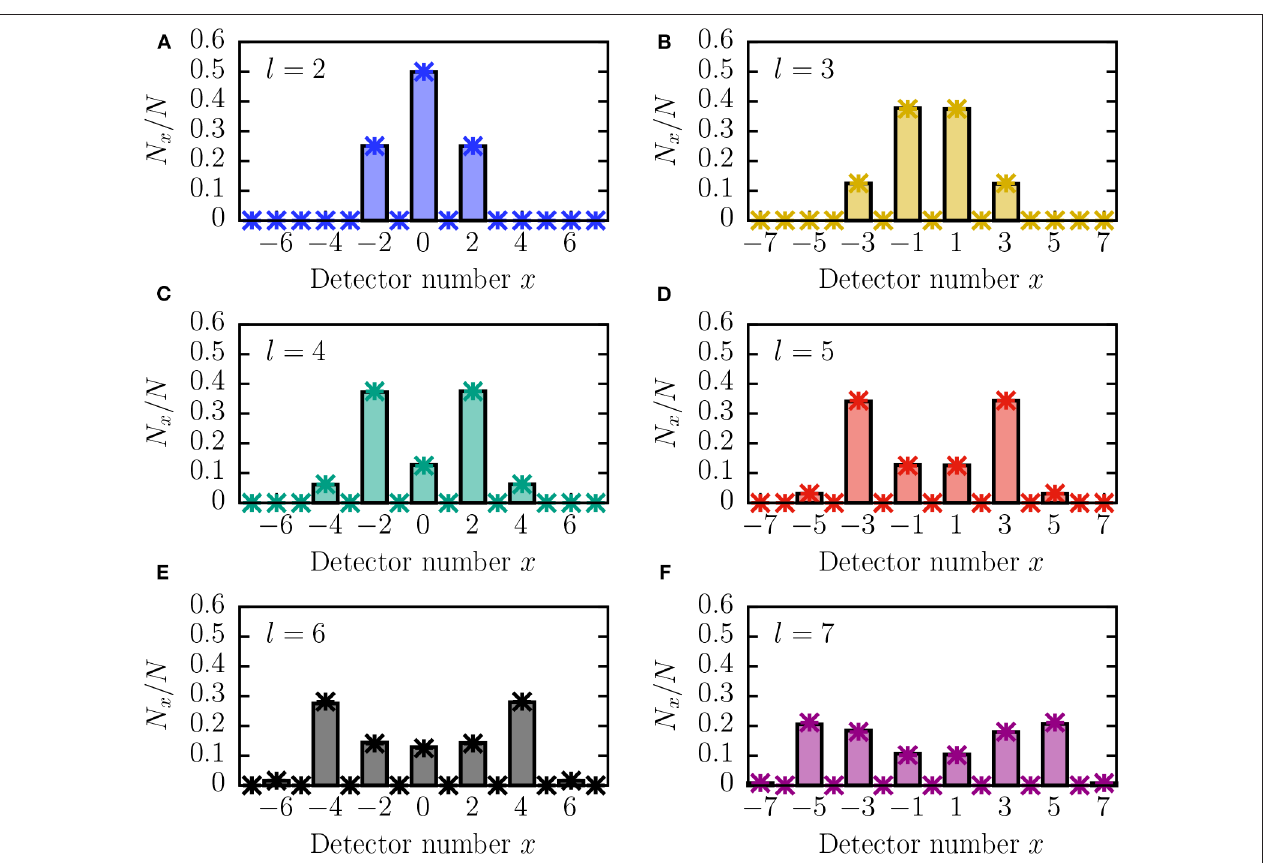
FIGURE 2 | Results for the normalized number of detector counts N x / N as a function of the detector number x , obtained by a DES of the QW for N π/ 2 and ϕ 2 π/ 2 and for different numbers of steps l repetitions, ϕ 1 2, ... ,7, corresponding to (A–F) . The distributions from the DES (bars) match with the = = − = analytical results for the QW (asterisks, see Table 1 ). For more than 3 steps, the distributions of the QW are broader than those of the SRW (see Table 1 ) because of interference